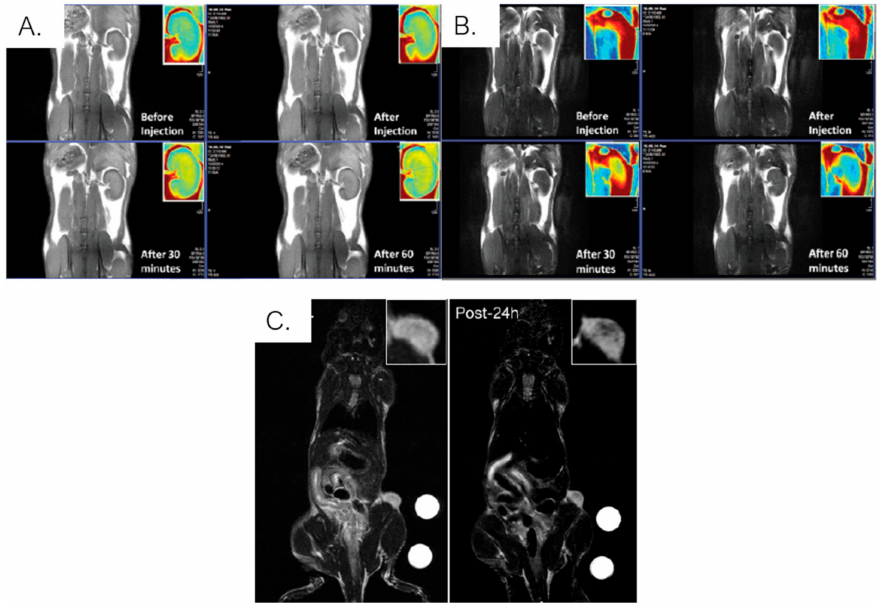
Figure 11. T 1 - ( A ) and T 2 -weighted ( B ) in vivo MR images before injection, immediately after and after 30 and 60 minutes of silica coated nanocubes. The contrast enhancement is clearly observed in the coronal images of the kidney. Adapted from [124] with permission from Royal Society of Chemistry 2020. ( C ) T2-weighted in vivo MR images before (left) and 24 h after (right) injection of BSA-coated nanocubes into mice bearing U87-MG tumor cells. The darkening of the tumor mass is clearly visible after the injection of nanoparticles. Adapted from [175] with permission from MDPI